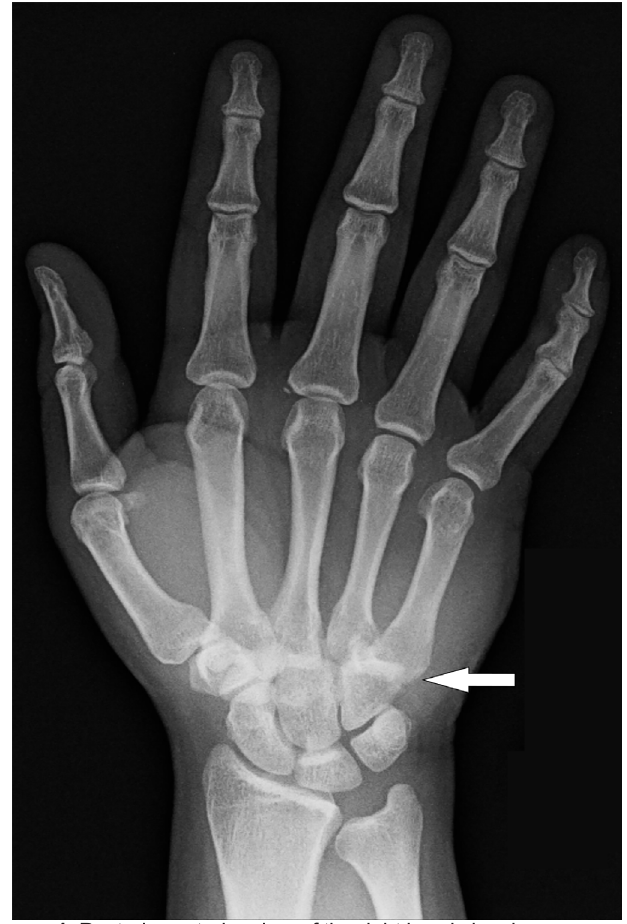
Image 1. Posterior-anterior view of the right hand showing an obscuring of the second through fifth carpometacarpal joints due to bony overlap